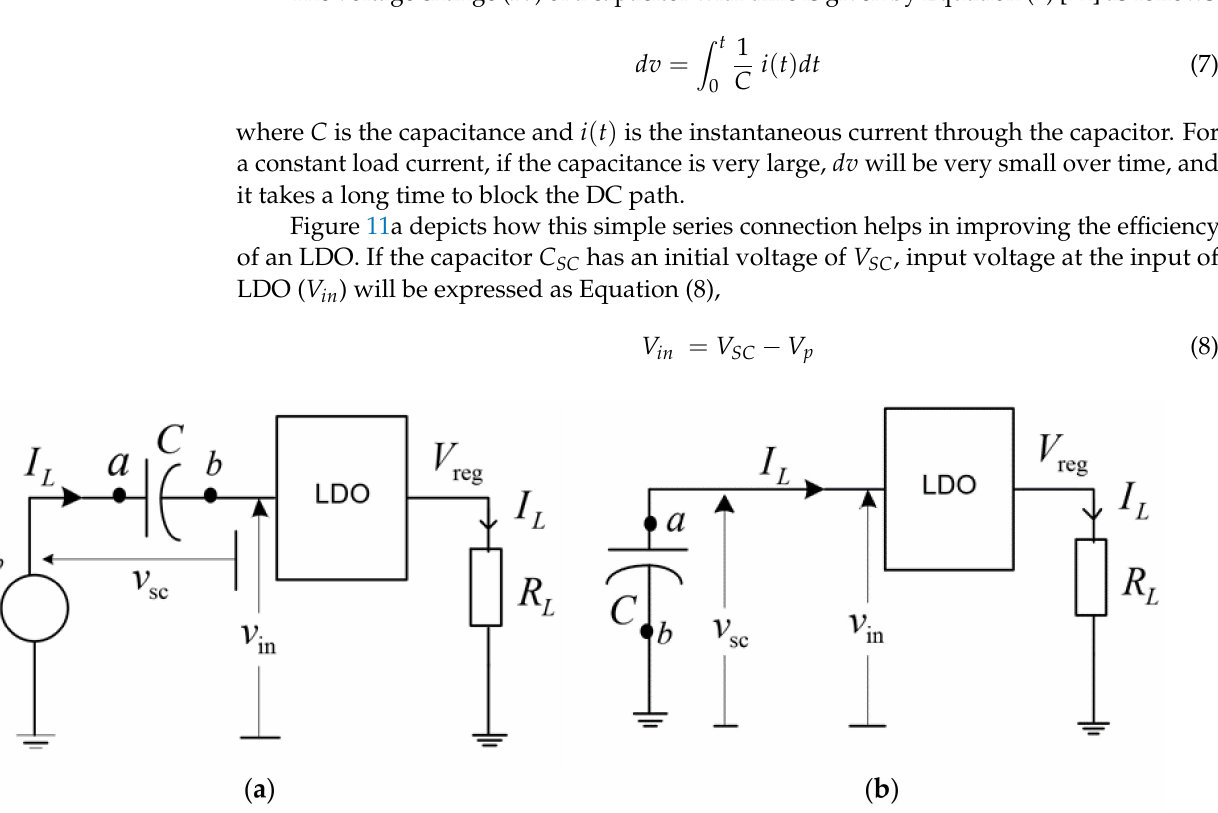
Figure 11. SCALDO configuration: ( a ) phase 1: supercapacitor charging circuit [72]; ( b ) phase 2: supercapacitor discharging circuit